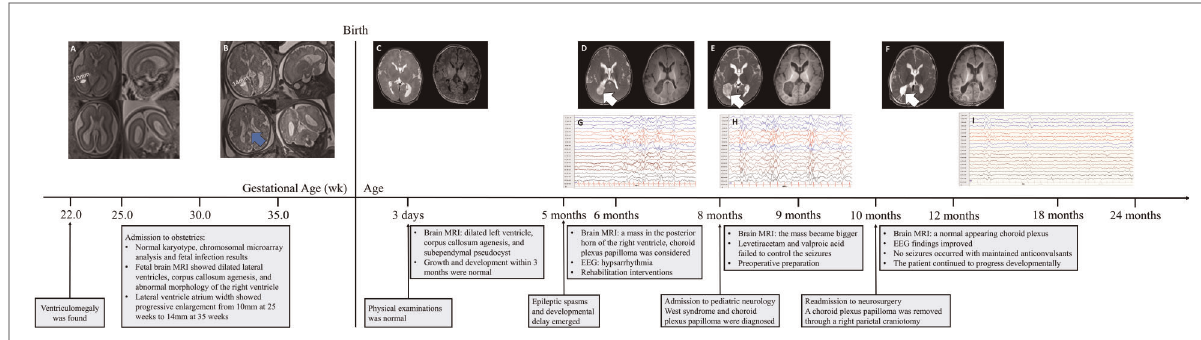
FIGURE 4 Clinical course of the patient and identi fi cation of a choroid plexus papilloma in the panel, the patient ’ s mother was admitted to our institution for prenatal counseling due to fetal ventriculomegaly at 22 weeks of gestation. Amniocentesis showed a Normal karyotype and chromosomal microarray analysis. Fetal infection results were within Normal limits. fetal brain magnetic resonance imaging was performed at 25 and 35 weeks, describing symmetrically dilated lateral ventricles, progressive enlargement (from 10 mm at 22 weeks to 14 mm at 35 weeks), corpus callosum agenesis (blue arrow), and abnormal morphology of the right ventricle (subpanels A, B ). A diagnosis of non-isolated ventriculomegaly was made and a female was delivered vaginally with Normal physical and neurological examinations. Brain MRI 3 days after birth showed dilated left